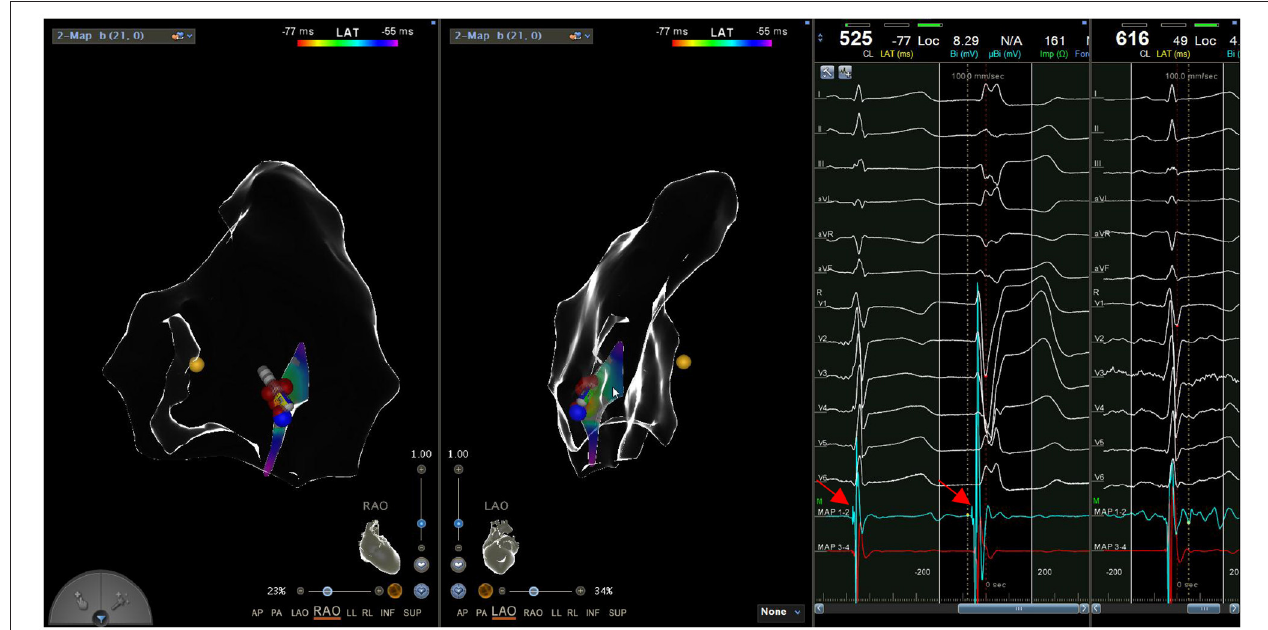
FIGURE 5 | A Purkinje potential (arrow) is recorded in both sinus rhythm and PVC in a continuous way.